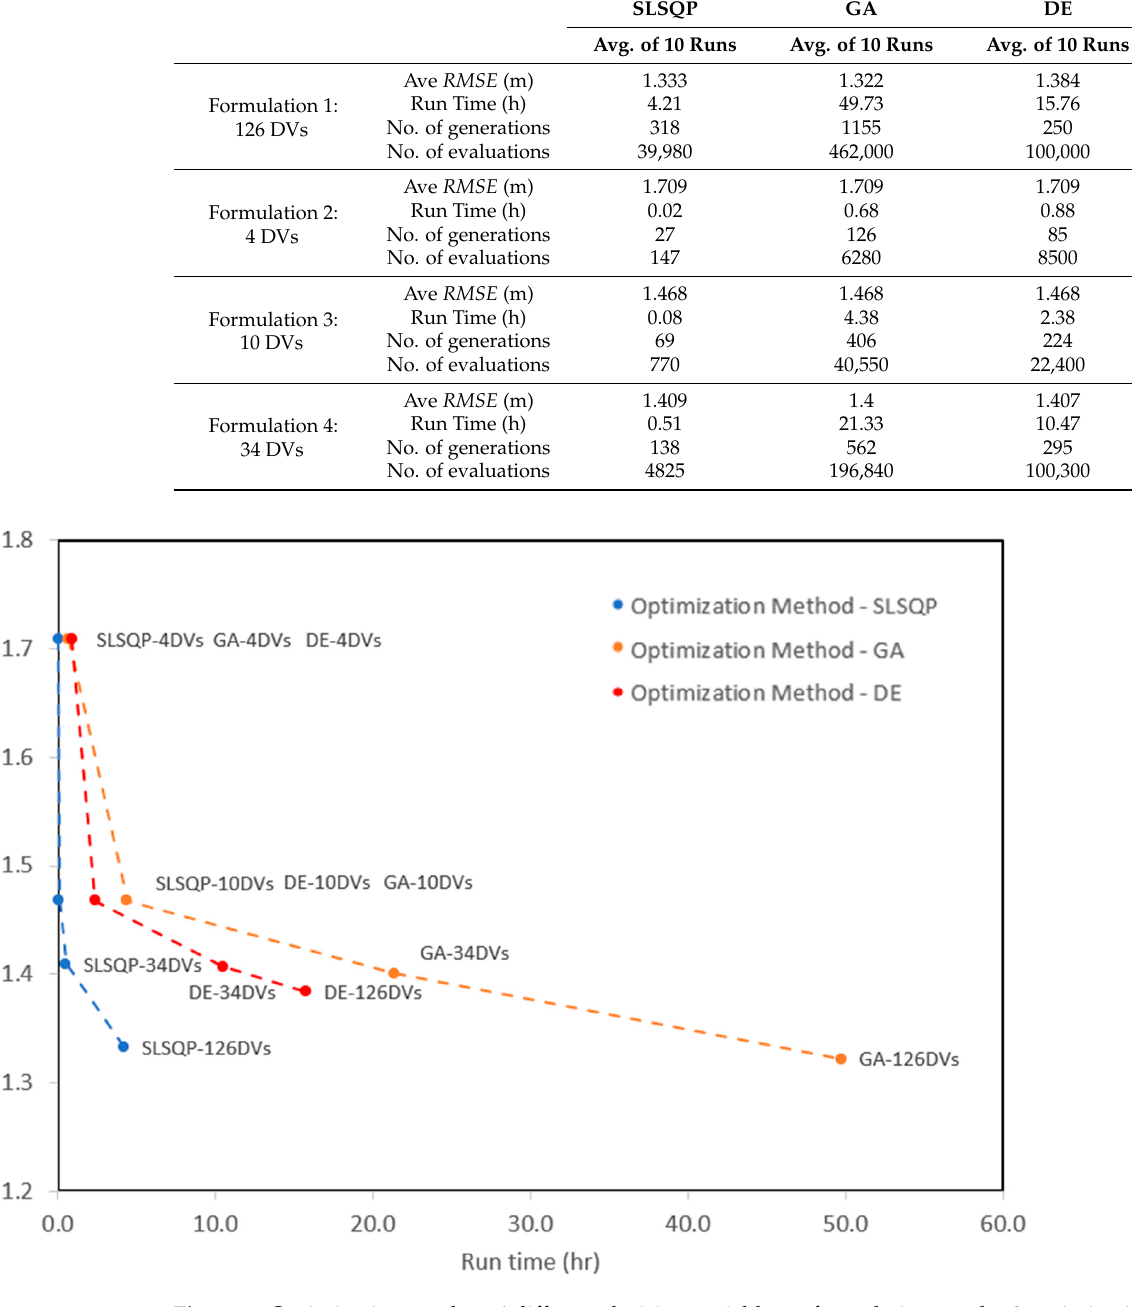
Figure 5. Optimization results—4 different decision variable set formulations under 3 optimization methods.